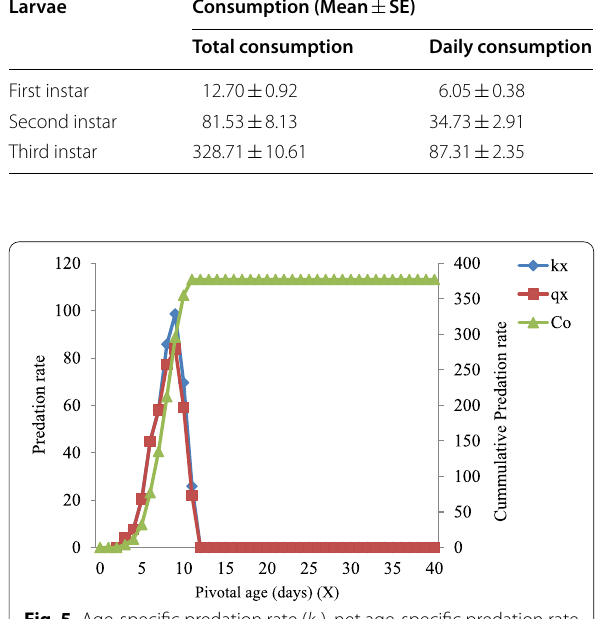
Fig. 5 Age-specific predation rate ( k x ), net age-specific predation rate ( q x ) and cumulative predation rate ( C o ) of S. pyrastri on B.